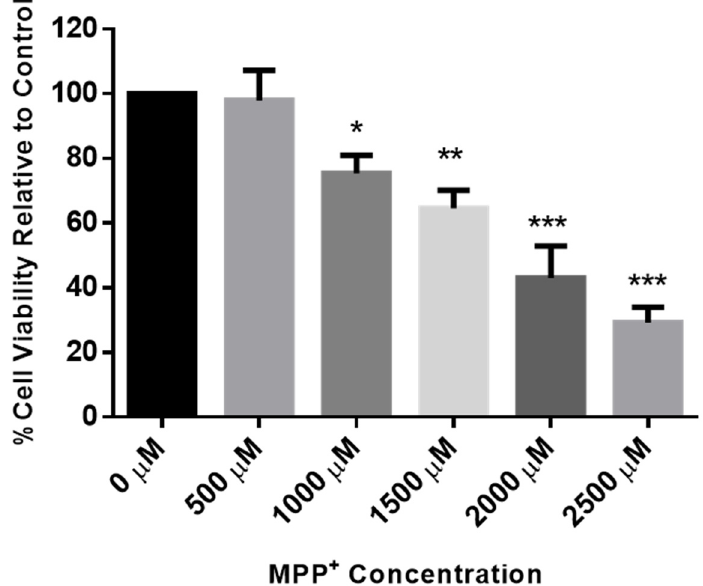
Figure 5. Dose–response of MPP + in SH-SY5Y cells. SH-SY5Y cells were treated with MPP + (500 µM–2500 µM), and after 24 h cell viability was assessed using MTT assays. Each bar represents mean percentage cell viability, and significance of difference is indicated with * ( p < 0.05), ** ( p < 0.01), and *** ( p < 0.001).